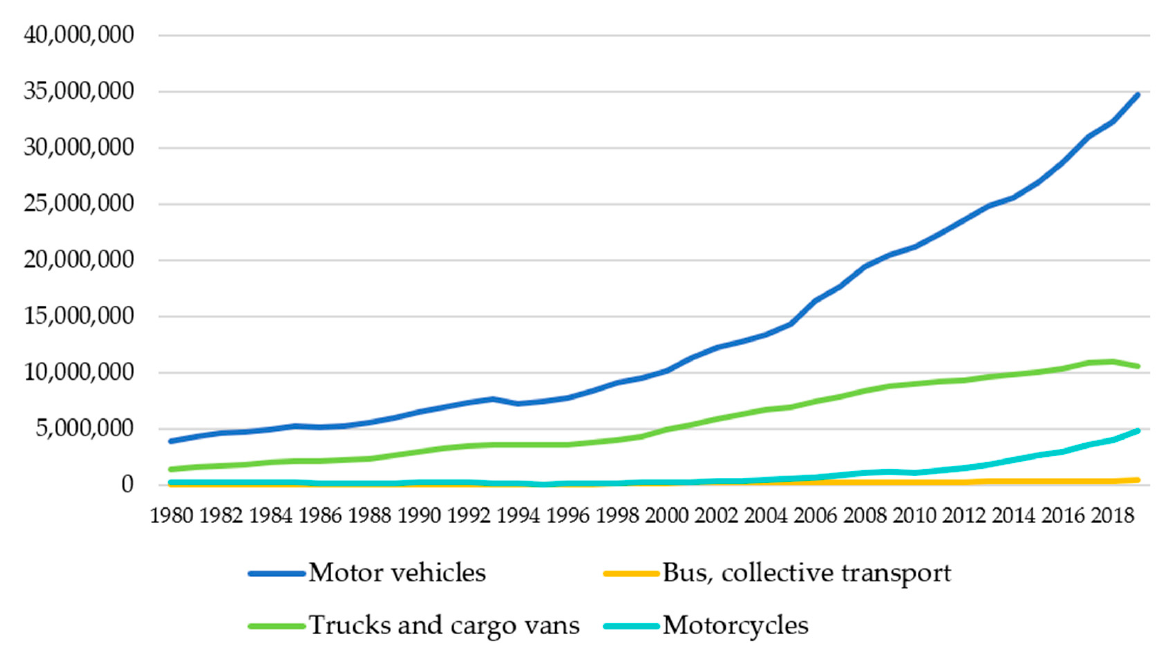
Figure 1. Number of registered cars in circulation at the national level from 1980 to 2019.